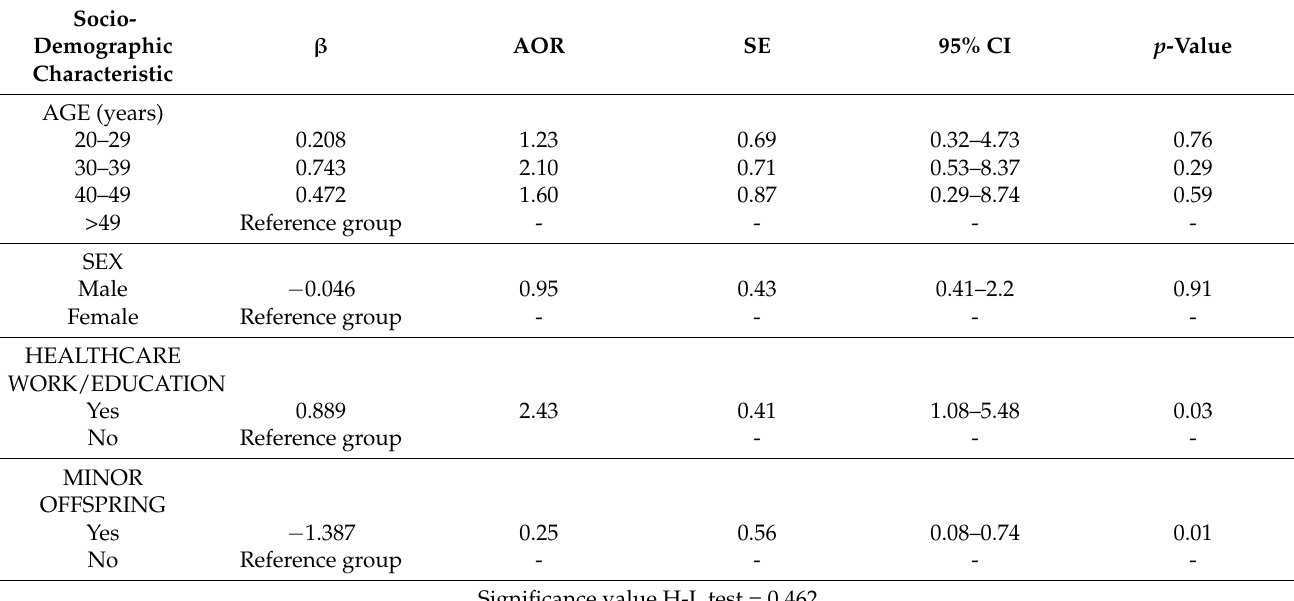
Table 4. Multivariate logistic regression analysis perfomed on 5-point Likert Scale statements (Section 2 of questionnaire). Note— β : regression coefficient. AOR: adjusted odds ratio.